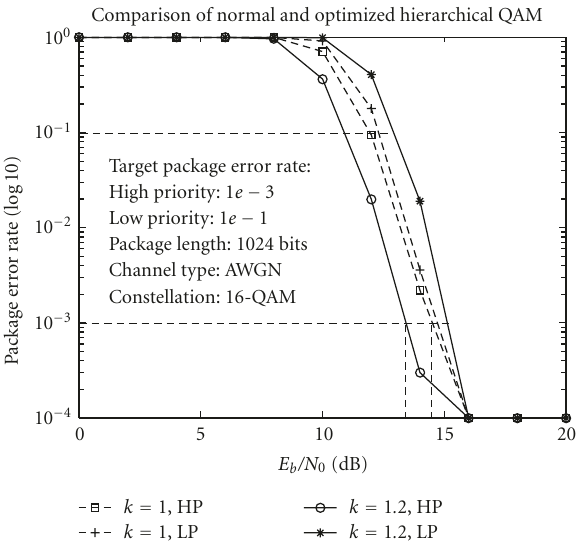
Figure 10: Package error rate versus SNR per bit.